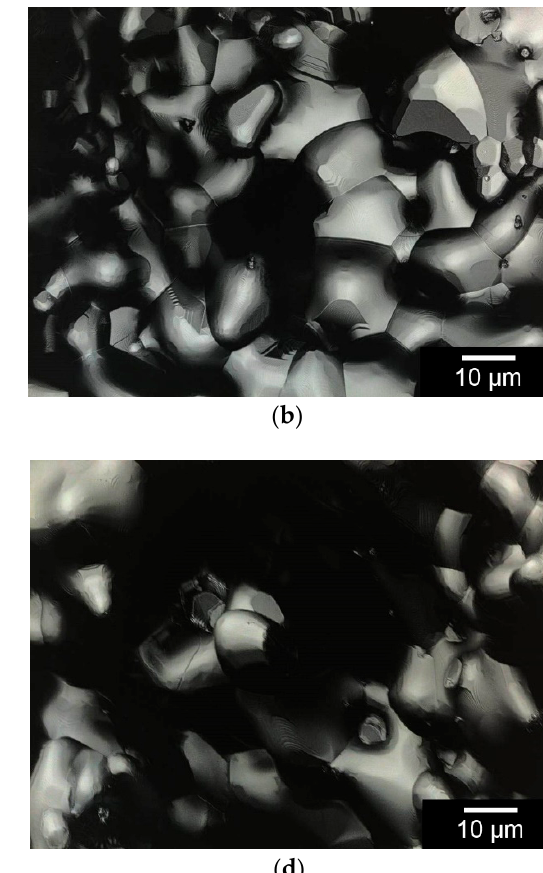
Figure 3. Pore size distribution ( a ): RMS ceramics and ( b ): Curasan ceramics.